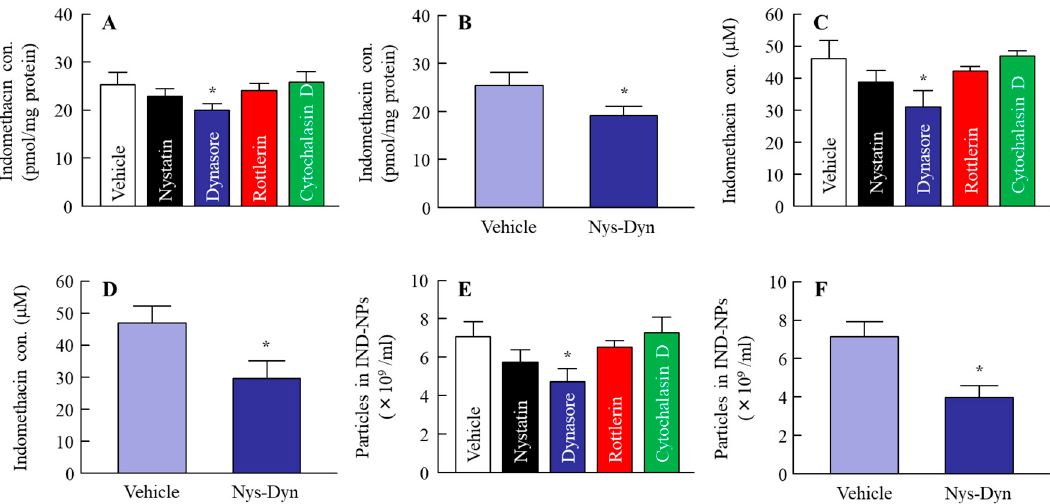
Figure 4. Penetration of IND-NPs through Caco-2 cell monolayers treated with endocytosis inhibitors. ( A , B ) Accumulation of indomethacin in the Caco-2 cell monolayers. ( C , D ) Penetration of indomethacin through Caco-2 cell monolayers. ( E , F ) Number of indomethacin nanoparticles in the basolateral side of Caco-2 cell monolayers. Nys-Dyn indicates co-treatment with nystatin and dynasore. n = 5–9. * P < 0.05 vs. vehicle for each category. Dynasore significantly attenuated the accumulation and penetration of indomethacin nanoparticles in Caco-2 cell monolayers.